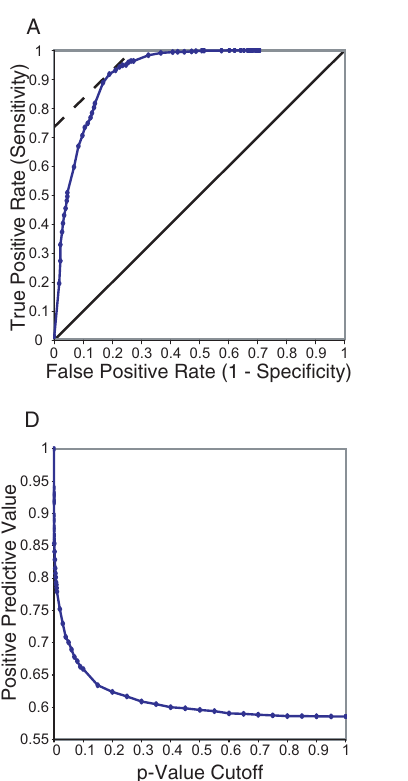
Figure 5. SAGE2Splice Achieves High Sensitivity but Relatively Low Specificity (A) The area under the ROC curve is 0.9232, indicating a candidate found by SAGE2Splice was much better than expected by random chance. Conversely, to achieve high specificity, the sensitivity (true positive rate) was significantly compromised. The tangent point of the dashed line is the optimal point when the costs of misclassifying positive and negative candidates are equal. This point corresponds to a p- value cutoff of 0.0025. (B) Analysis of the ROC curve for the donor splice junctions indicates a cutoff p- value of 0.06 as the optimal point. (C) For the acceptor splice junctions, the optimal cutoff p- value is determined to be 0.15. (D) The positive predictive value indicates that a high probability (greater than 0.9) of correct predictions requires a restrictive p- value (less than 0.0001). DOI: 10.1371/journal.pcbi.0020034.g005